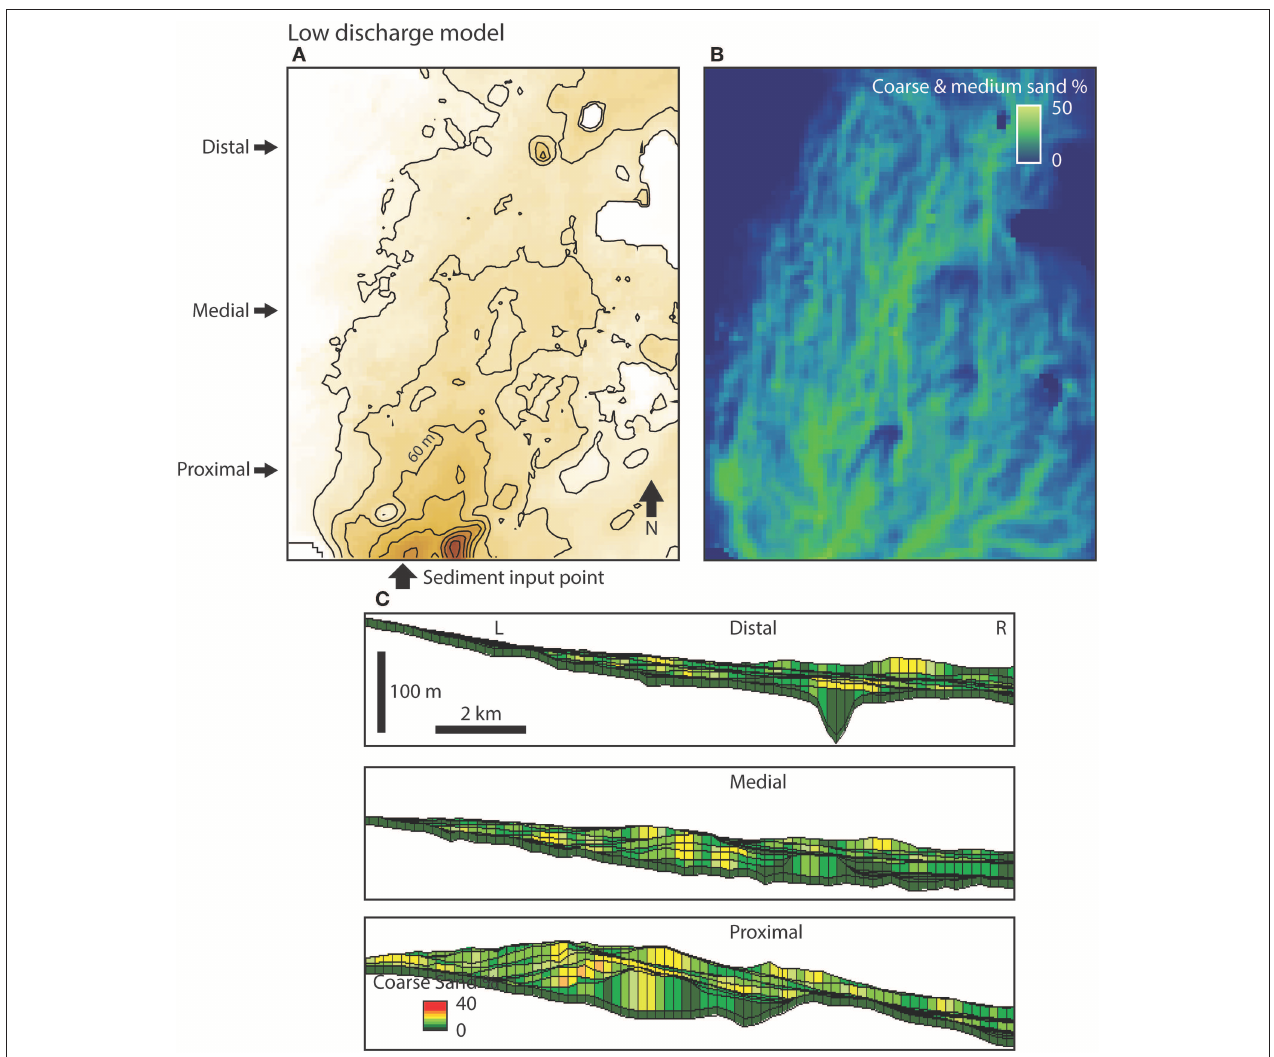
FIGURE 9 | (A) Isochore map of the low discharge model. (B) Coarse and medium sand percentage within the model. (C) Proximal, medial, and distal cross sections showing the coarse sand content in the model. Left (L) and right (R) orientations in cross sections are left and right in maps. Cross-section locations are indicated in part (A)